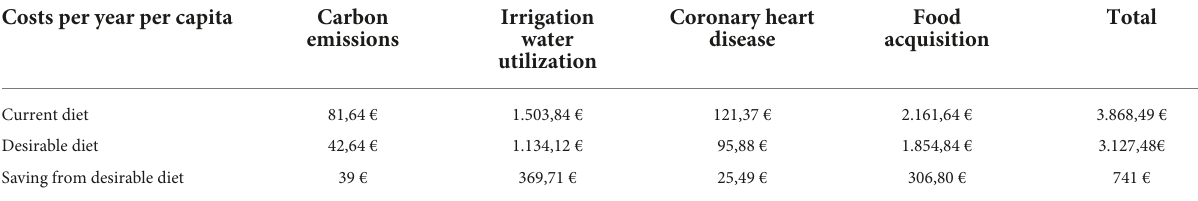
TABLE 5 Costs per year per capita for each diet and yearly savings from the desirable diet adoption (Source: Authors). Costs per year per capita Carbon Irrigation emissions water